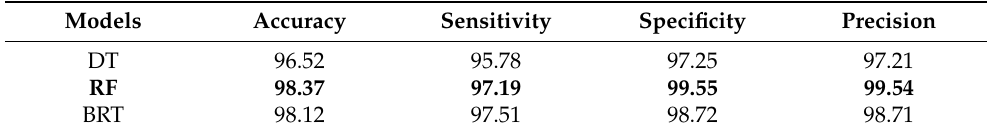
Table 7. Performance comparison for decision tree (DT), boosted regression tree (BRT), and random forest (RF).